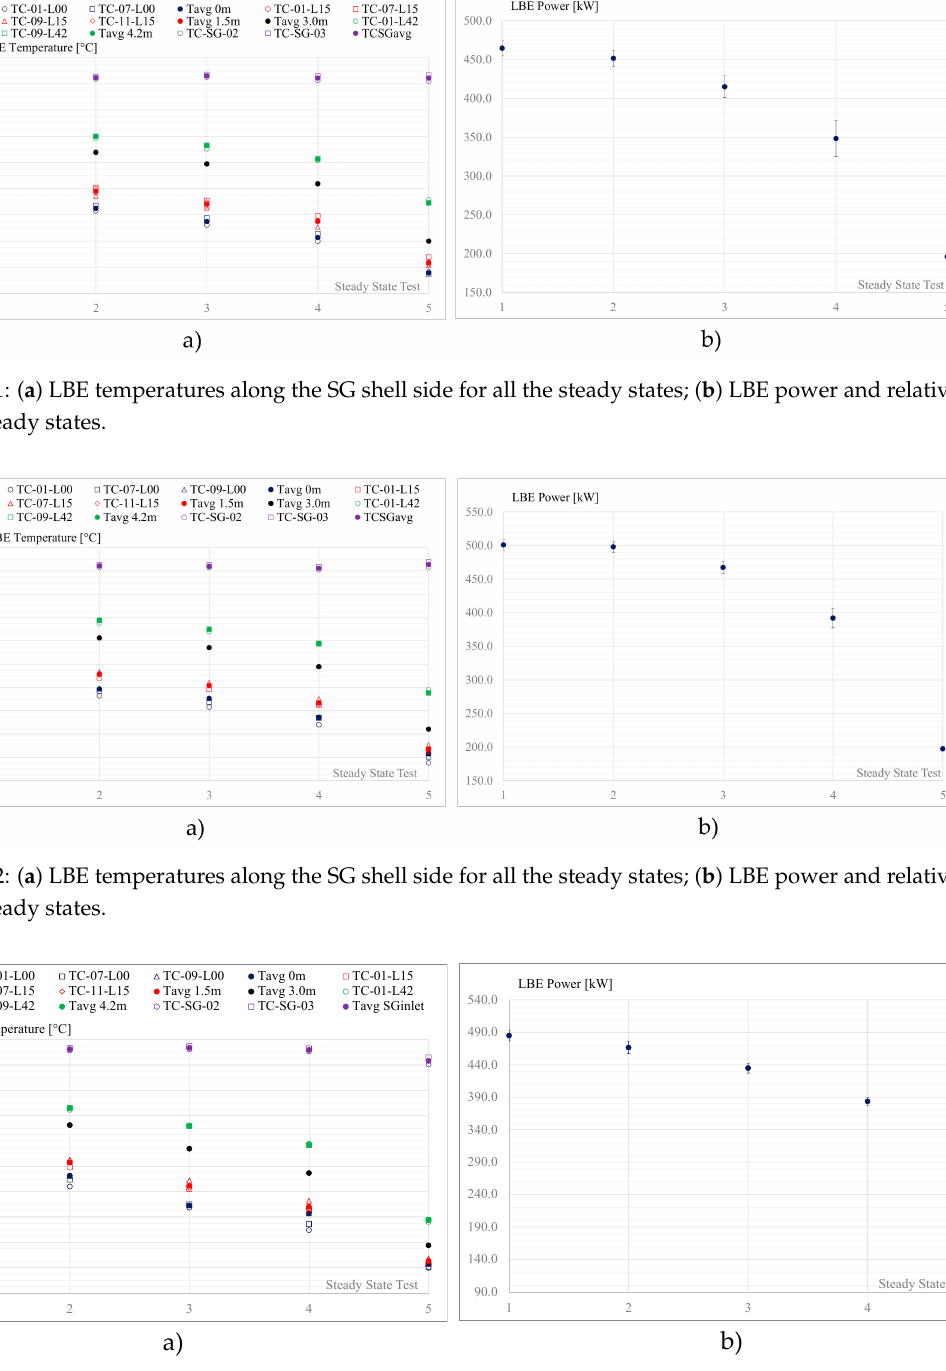
Figure 8. EF-T4: ( a ) LBE temperatures along the SG shell side for all the steady states; ( b ) LBE power and relative stand- ard deviation at steady states .